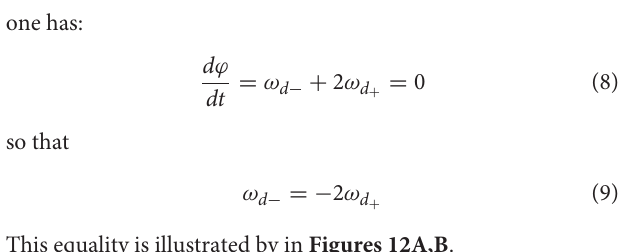
Frontiers in Physics |